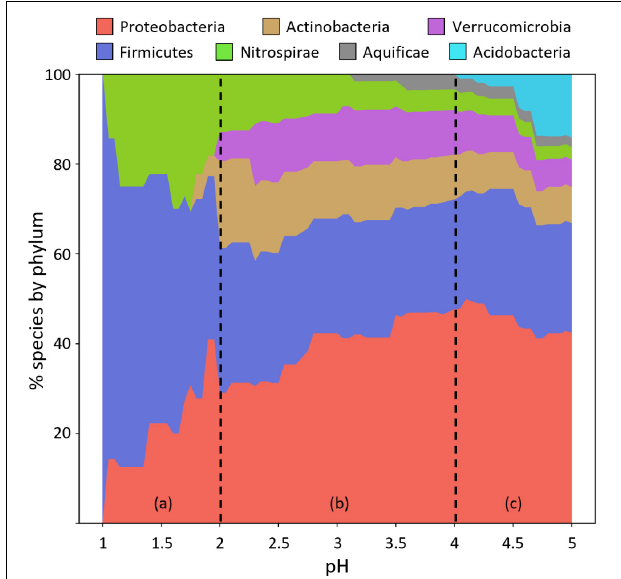
FIGURE 2 | Distribution of acidophilic species with sequenced genomes by phylum across pH. Cumulative plot of relative abundance (%) of acidophiles across pH. Percentages indicate species that can live at or below a given pH. (a–c) Indicate pH ranges 1–2, 2–4, and 4–5, respectively. The phyla are color-coded. Phylum Armatimonadetes has only one acidophilic species and is not shown.